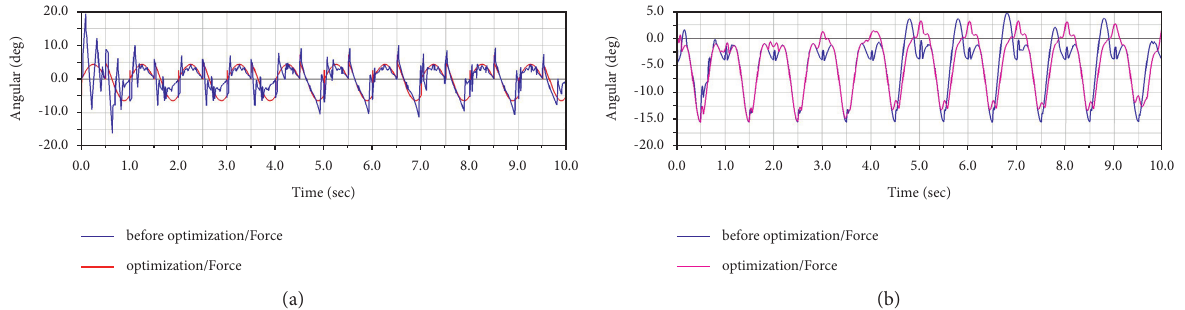
Figure 7: The attitude angle changes after the body under external force. (a) Roll angle of the body. (b) Pitch angle of the body.